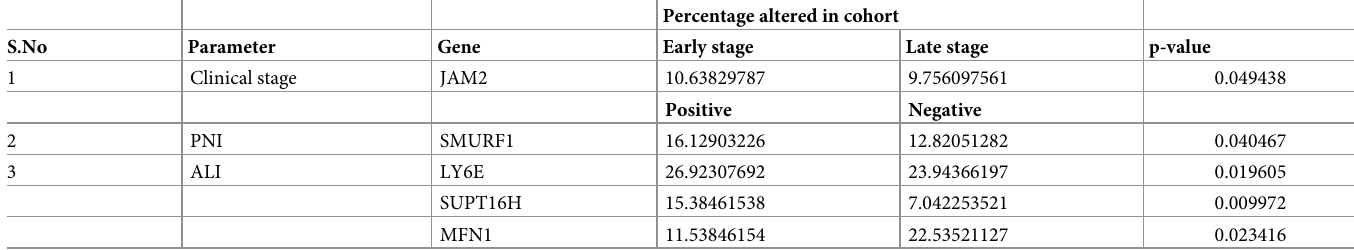
Table 1. Differential mRNA z-score expression profiling between the altered cases in association with clinico-pathological parameters in tongue